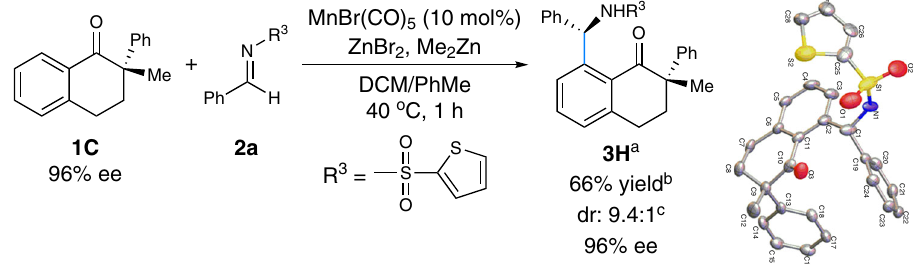
Fig. 5 A diastereoselective mono -C – H addition reaction using chiral ketone 1 C . a The major diastereo-isomer was shown. b Combined isolated yield. c Determined by 1 H NMR analysis of the crude product. DCM